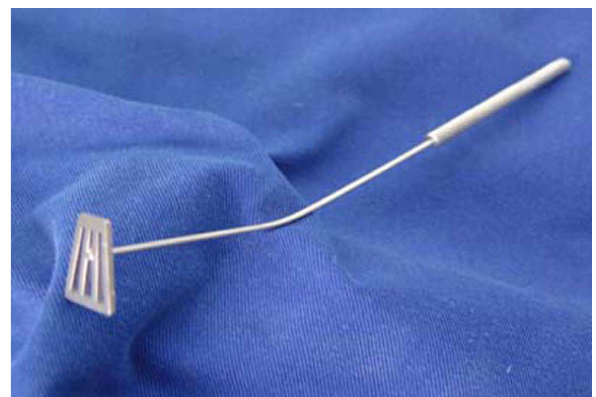
Fig. 8 – Measuring instruments ranging in length from 20 to 35 mm are used to confirm standardization of the